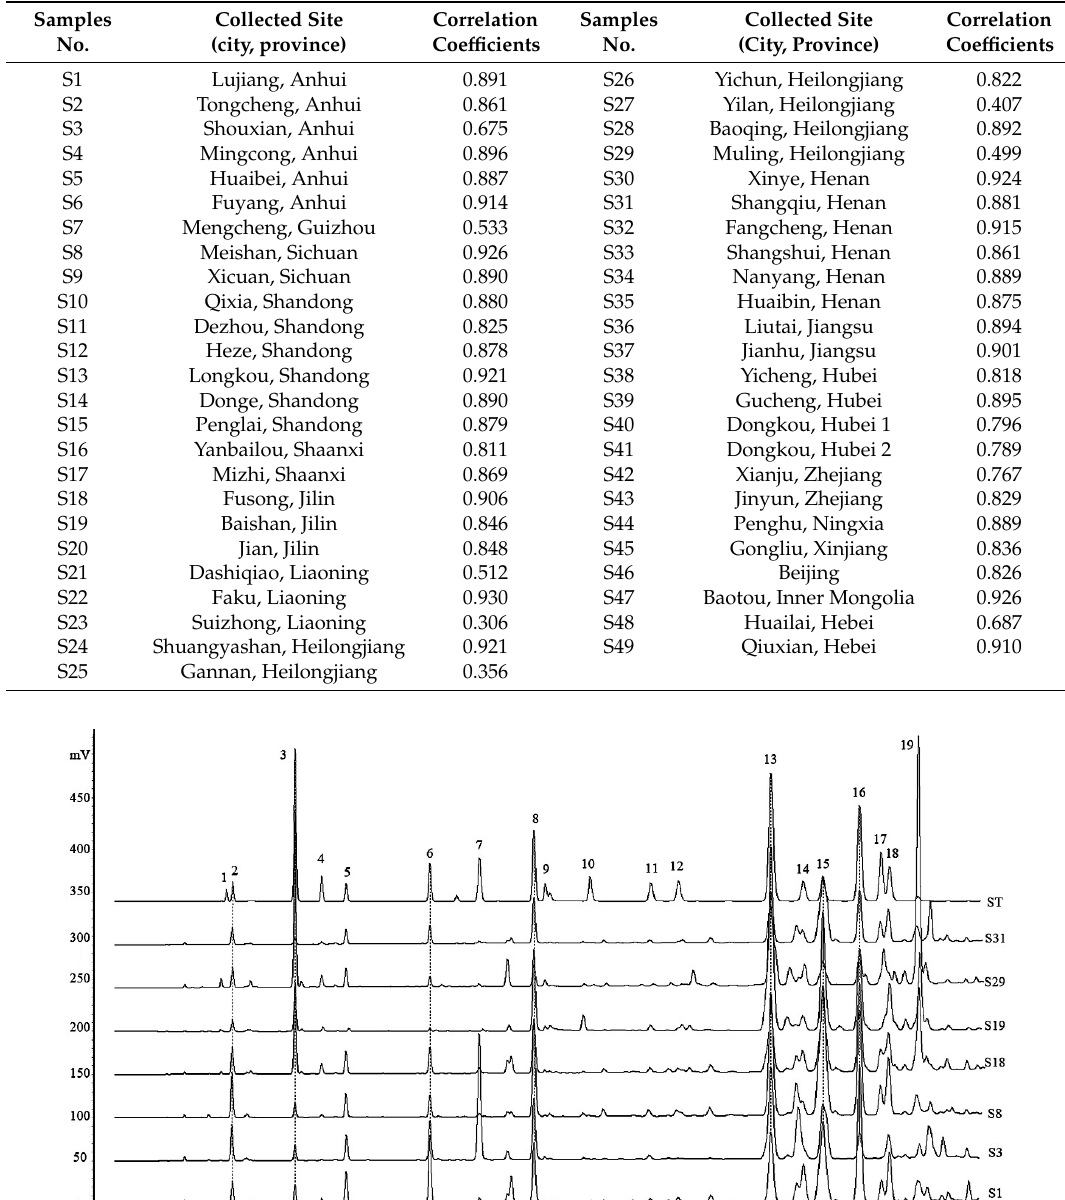
Table 1. Collection site correlation coe ffi cients of 49 Chinese propolis.